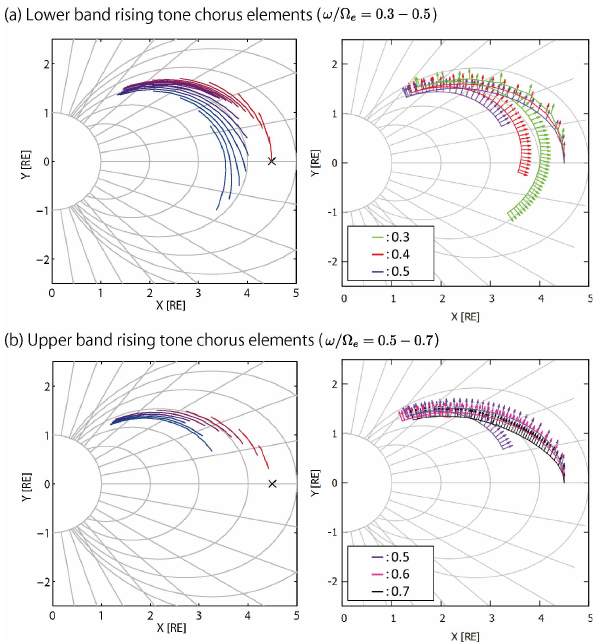
Fig. 3. Ray tracing of rising chorus starting from outside the plasma- pause at L = 4 . 5 for (a) lower-band chorus element, frequency span f = 0 . 3–0.5 (cid:127) e / 2 π (Hz) and (b) upper-band chorus element, fre- quency span f = 0 . 5–0.7 (cid:127) e / 2 π (Hz). Pulse length is 50ms in both cases. Left-hand panel shows pulse evolution, right-hand panel k vector evolution at f = 0 . 3, 0.4, 0.5 (cid:127) e / 2 π (Hz) for the lower band and f = 0 . 5, 0.6, 0.7 (cid:127) e / 2 π (Hz) for the upper